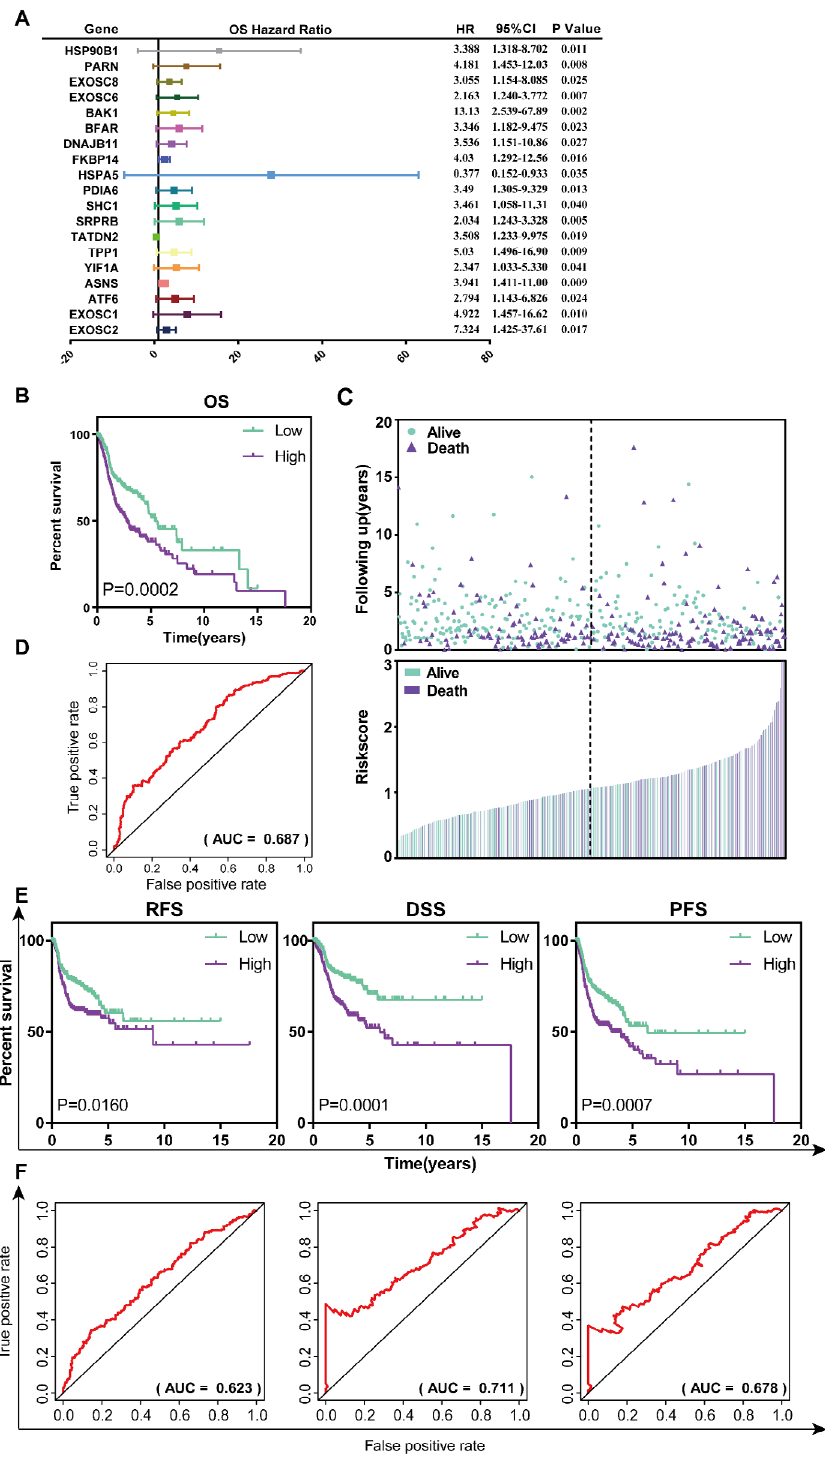
Fig. 3 Construction of the ERS-related prognostic signature for OS of HNSCC in the TCGA dataset. ( A ) 19 genes related to OS of HNSCC were obtained by utilizing univariate Cox regression. ( B ) Kaplan–Meier curves of OS of low- and high- risk groups stratified by the risk score in HNSCC. ( C ) The distributions of risk scores and patient survival status for HNSCC. ( D ) ROC curve for the 5-year OS prediction by the ERS-related signature. ( E ) Kaplan–Meier curves of RFS, DSS and PFS of low- and high- risk groups stratified by the risk score in HNSCC, respectively. ( F ) ROC curves for the 5-year RFS, DSS and PFS prediction by the ERS-related signature,